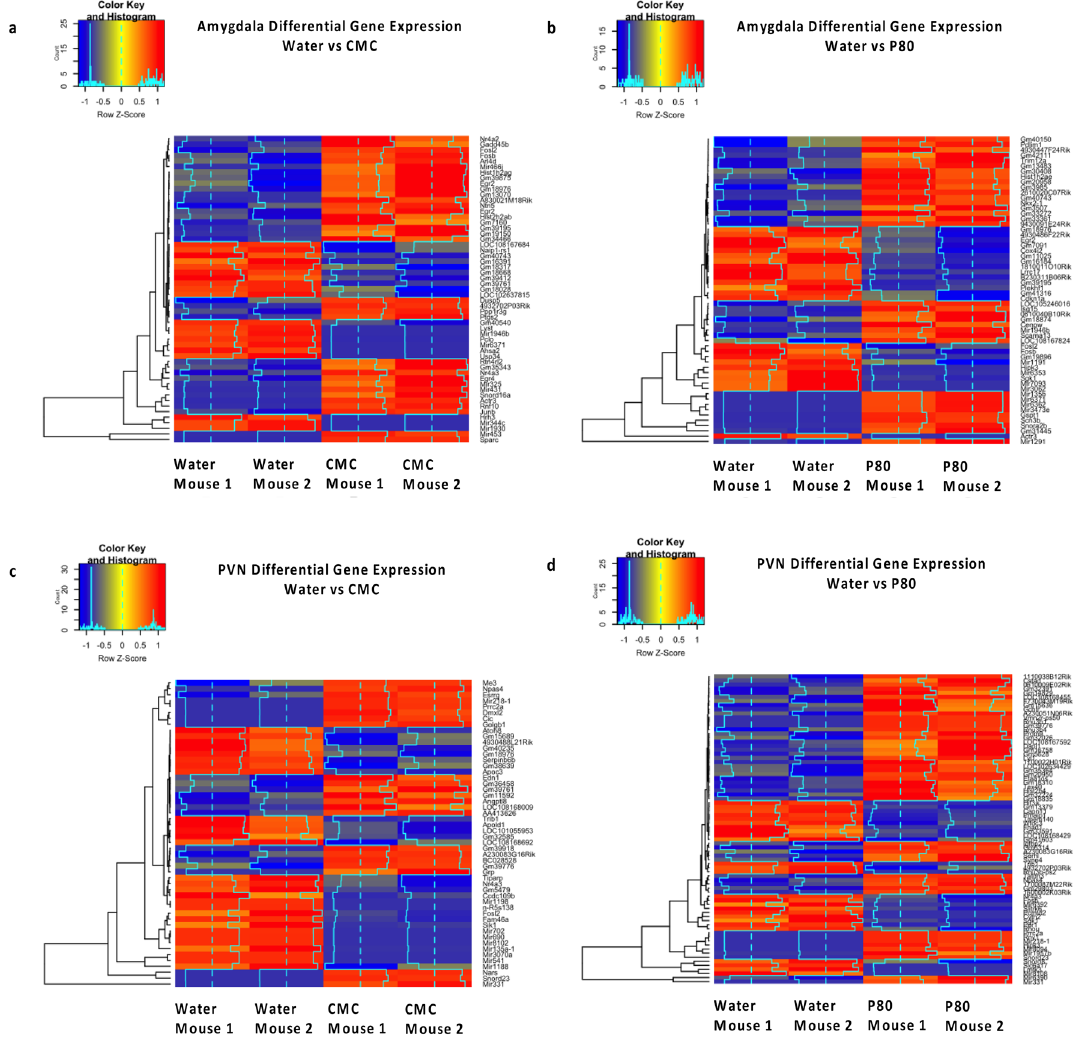
Figure 4. Heatmaps show z-score normalized relative expression of differentially expressed genes that met criteria (FC > 1, adj.p-value < 0.05). Hierarchical clustering based on Euclidian distance of 56 differentially expressed genes in the amygdala after CMC treatment and 59 with P80 treatment. 52 differentially expressed genes in the PVN after CMC treatment and 76 with P80 treatment are listed. Genes are indicated in rows and animals are in columns. Blue indicates downregulation and red upregulation of the differentially expressed genes. Heatmaps were generated using the gplots and RColorBrewer libraries in